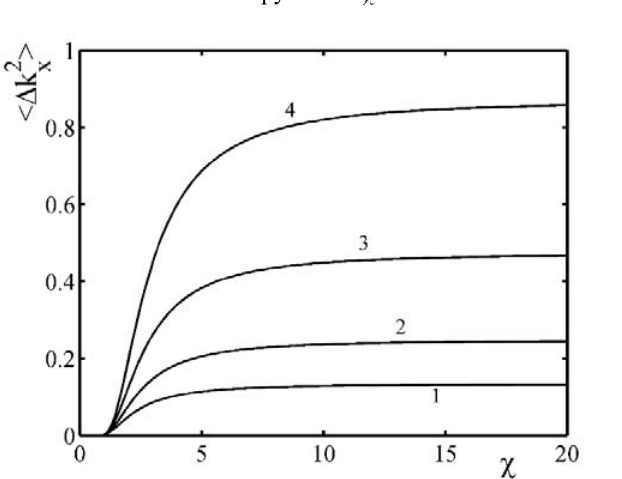
Figure 3: Plots of the displacement of the SPS as a function of anisotropy factor .